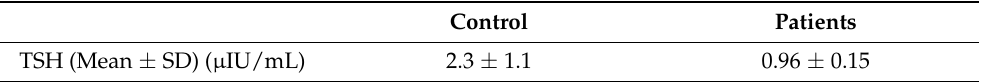
Table 3. Comparison between TSH values in normal healthy control and thyroidectomized patients.